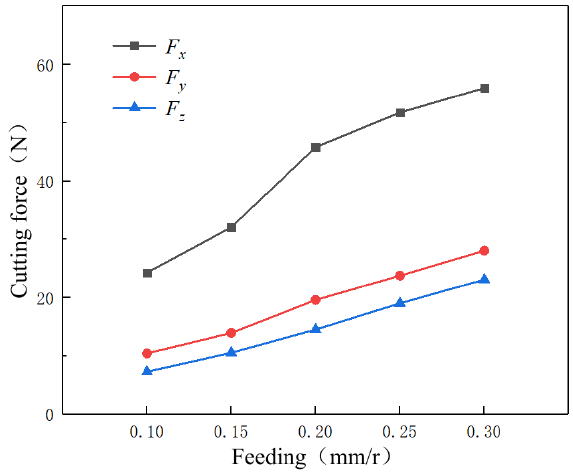
Figure 11. Variation trend of the cutting force at different feed rates.